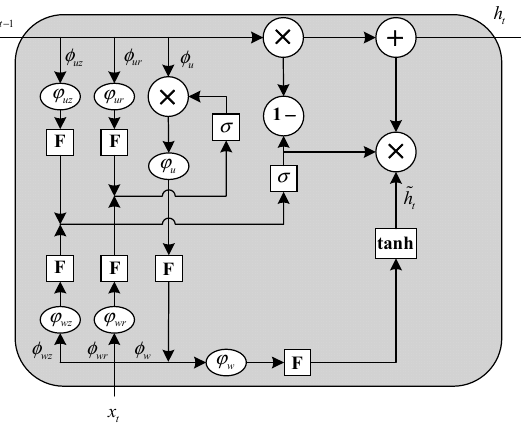
Figure 3. Diagram of QWGRU model.